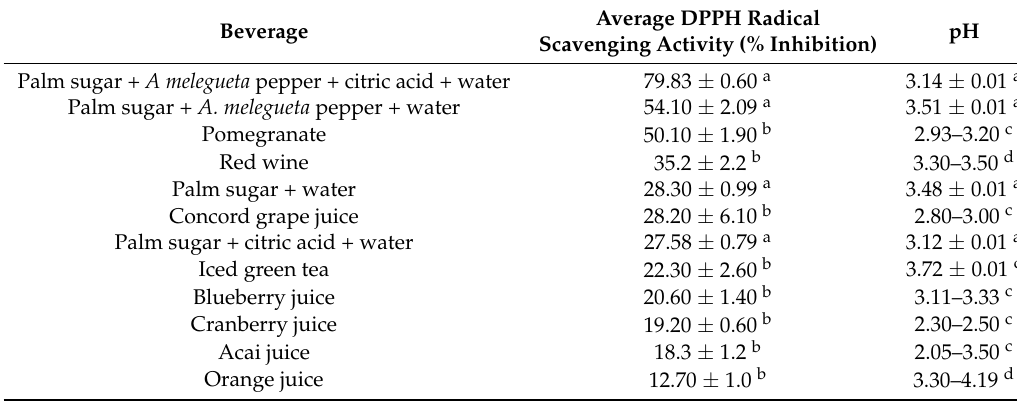
Table 8. Comparison of DPPH and pH of formulations with reported values for beverages with reported health